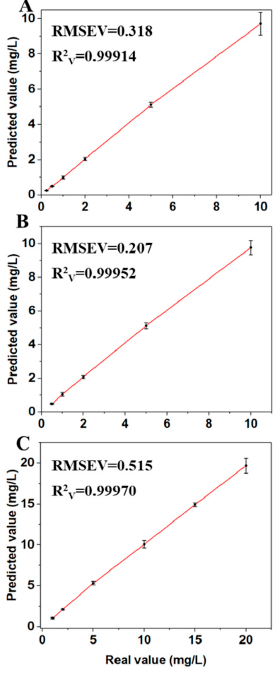
Figure 5. The predicted values and deviations of fonofos ( A ), phosmet ( B ), and sulfoxaflor ( C ) of different concentrations in paddy water, by using the optimal models.